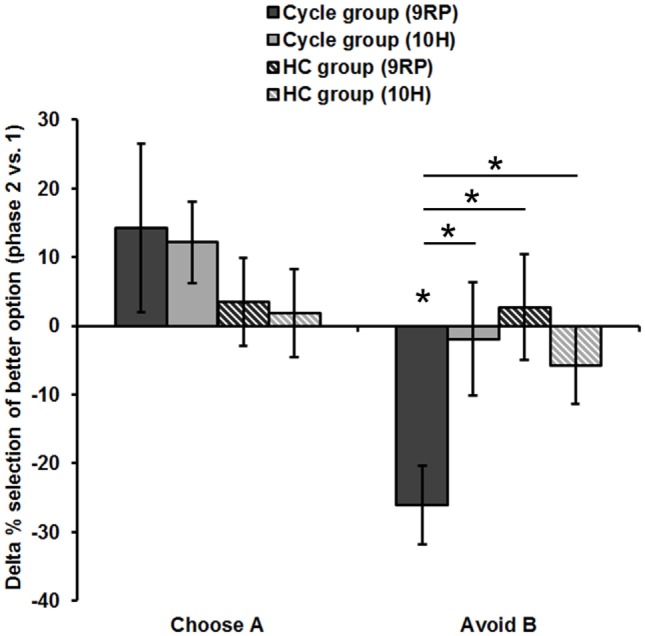
Difference in reinforcement learning capacity between phases (session 2). Displayed is the Delta of the late minus early FP and of the ON- minus OFF-phase, respectively. Only the 9RP genotype showed a significant phase-related change in punishment avoidance capacity. Significant differences (p < 0.05, two-tailed) from zero and between genotypes and groups, respectively, are marked with an asterisk. Phase 1, early FP or OFF-phase; phase 2, late FP or ON-phase.